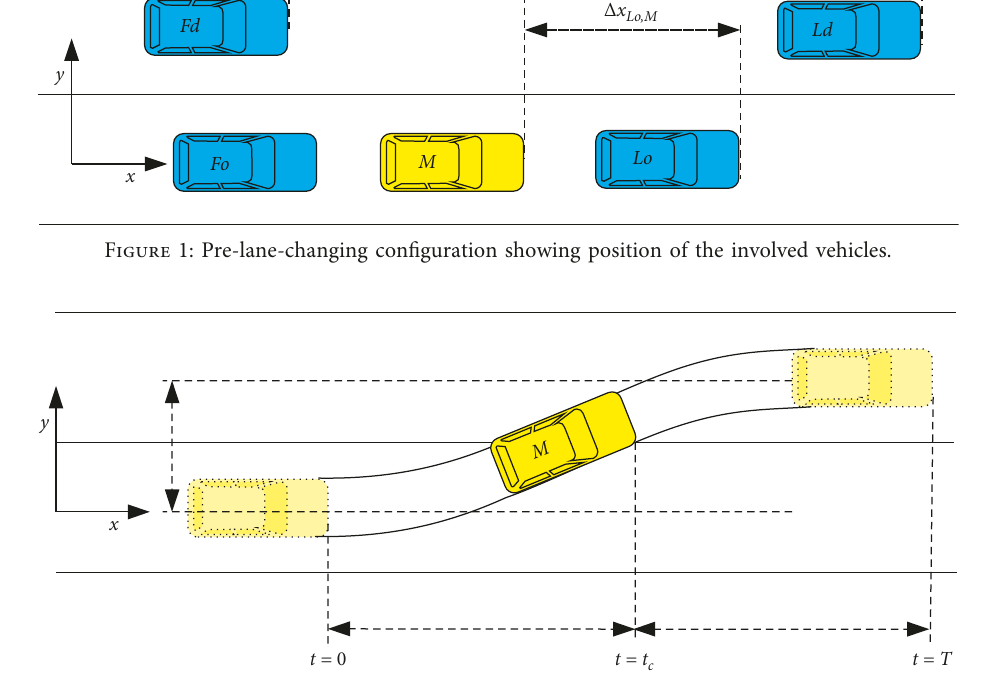
Figure 2: Discretionary lane-changing